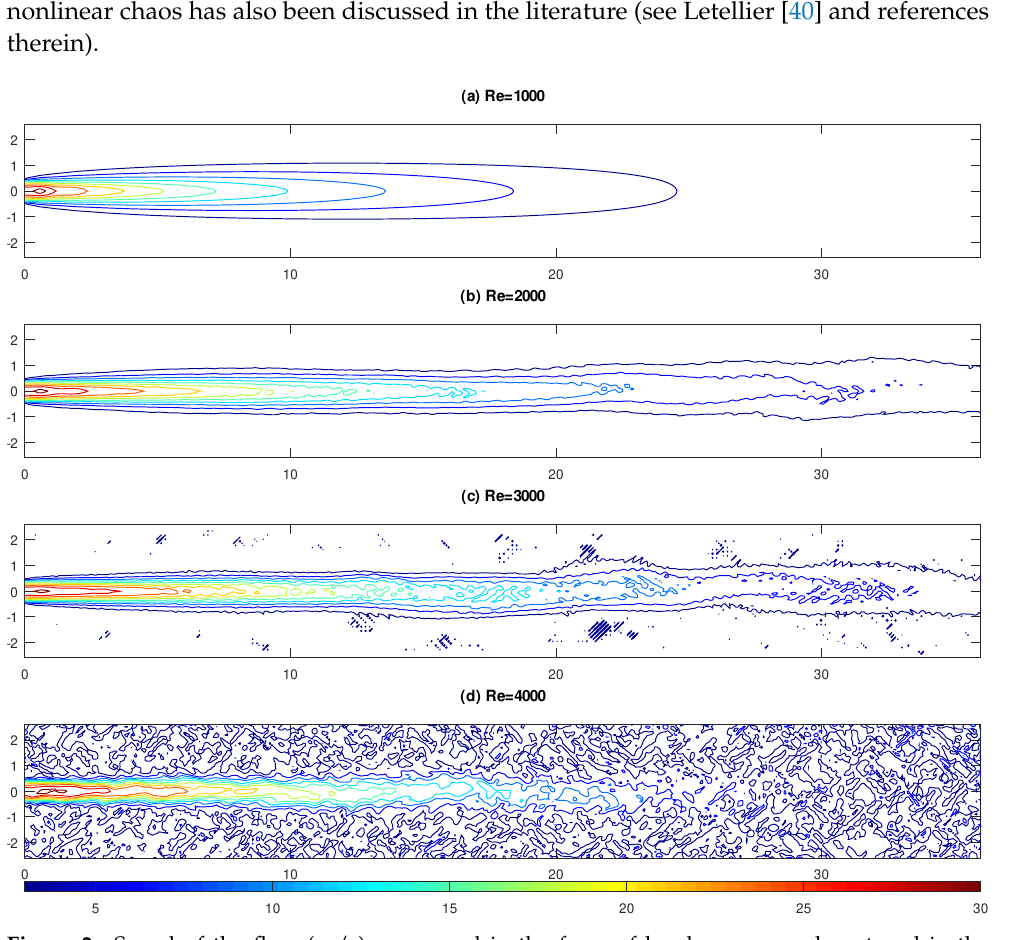
Figure 2. Speed of the flow (m/s), expressed in the form of level curves, and captured in the longitudinal symmetry plane of the pipe at the elapsed time t = 0.15 s for ( a ) Re = 1000, ( b ) Re = 2000, ( c ) Re = 3000, and ( d ) Re =